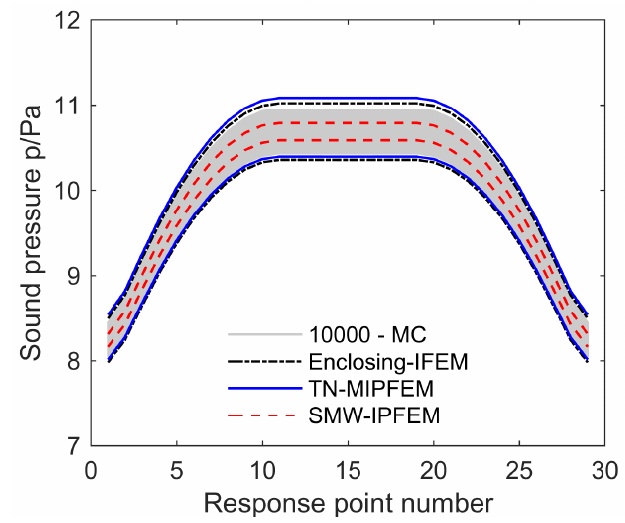
Figure 14. The sound pressure along the midfaceline at frequency 100 Hz.